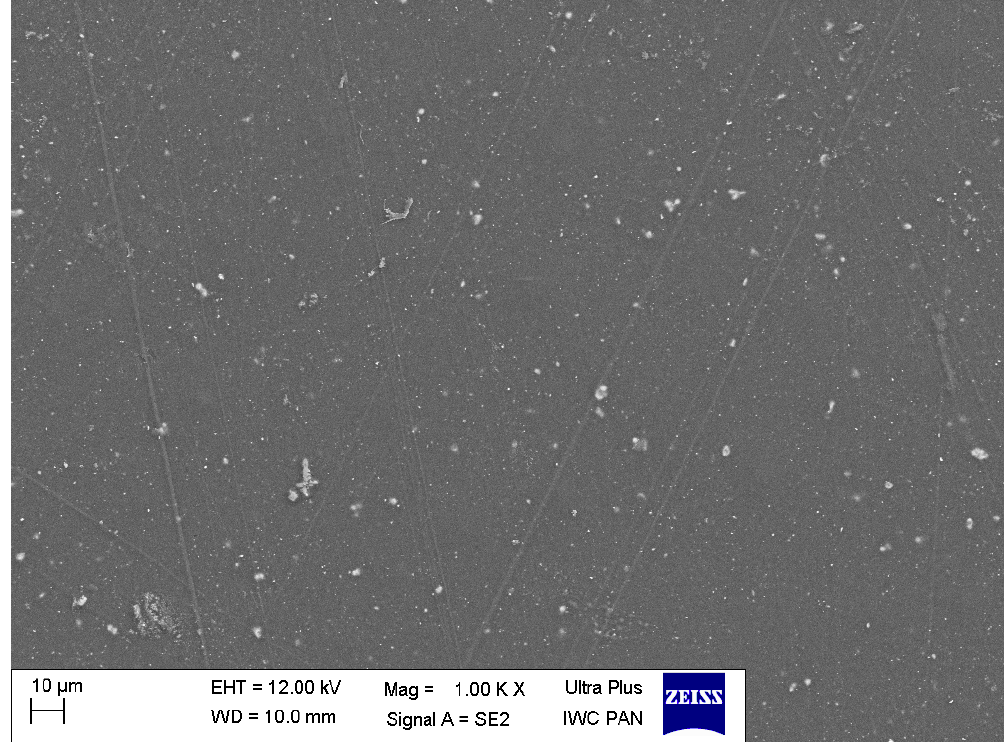
= 1 wt%). Figure 5. Representative SEM image of the nanocomposite (TiO 2 NPs Cp = 1 wt%). 2 NPs Cp